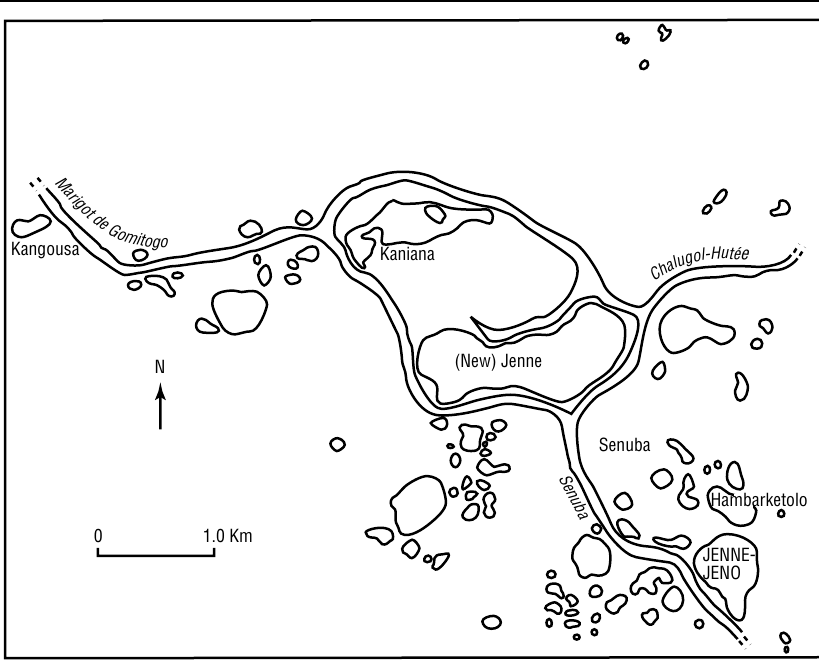
Figure 15 – Trading spheres of Jenne-Jeno; immediate (0–50 Km); Figure 16 – Jenne-Jeno Urban